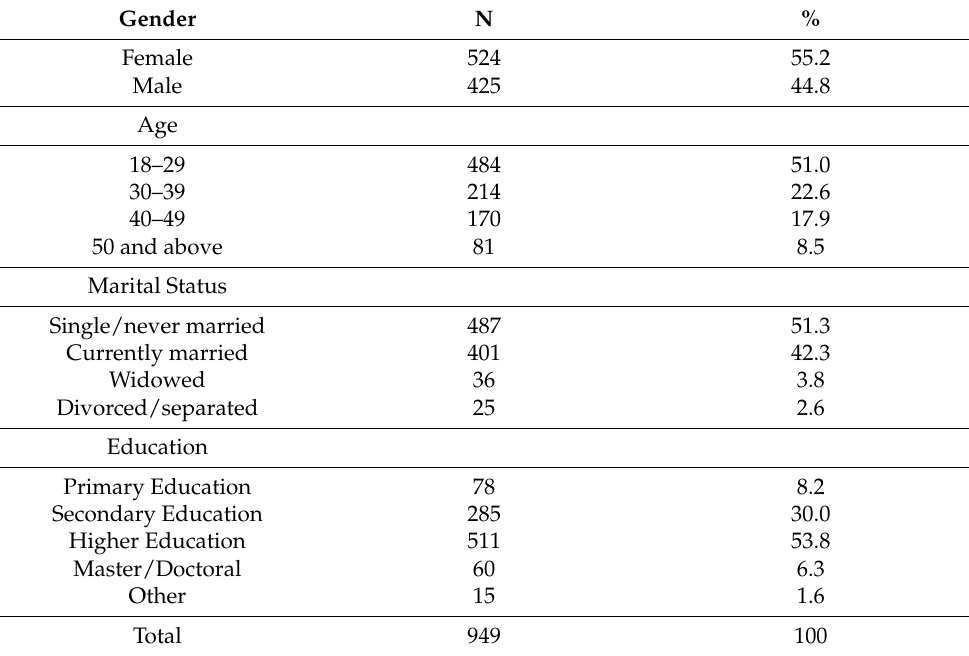
Table 2. Profile of the participants of the epidemiologic study.